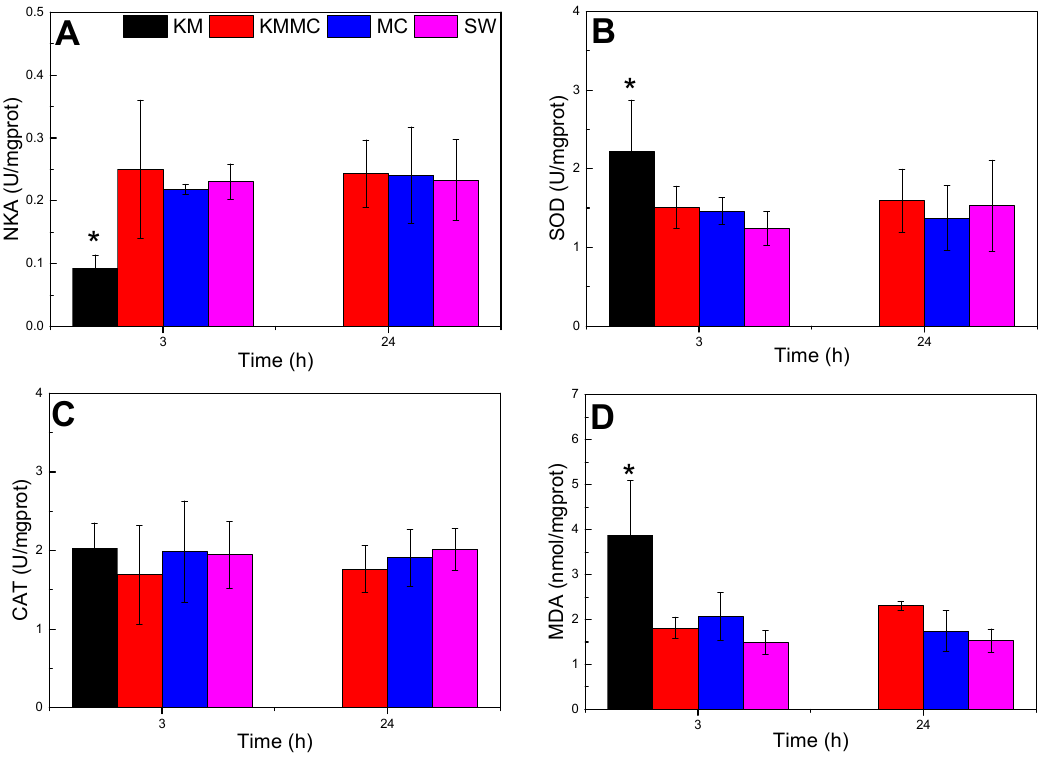
Figure 4. Changes in the biochemical and physiological indexes of different groups of marine medaka. ( A ) NKA activity, ( B ) SOD activity, ( C ) CAT activity, and ( D ) MDA content; * significant difference compared with SW group at p < 0.05.